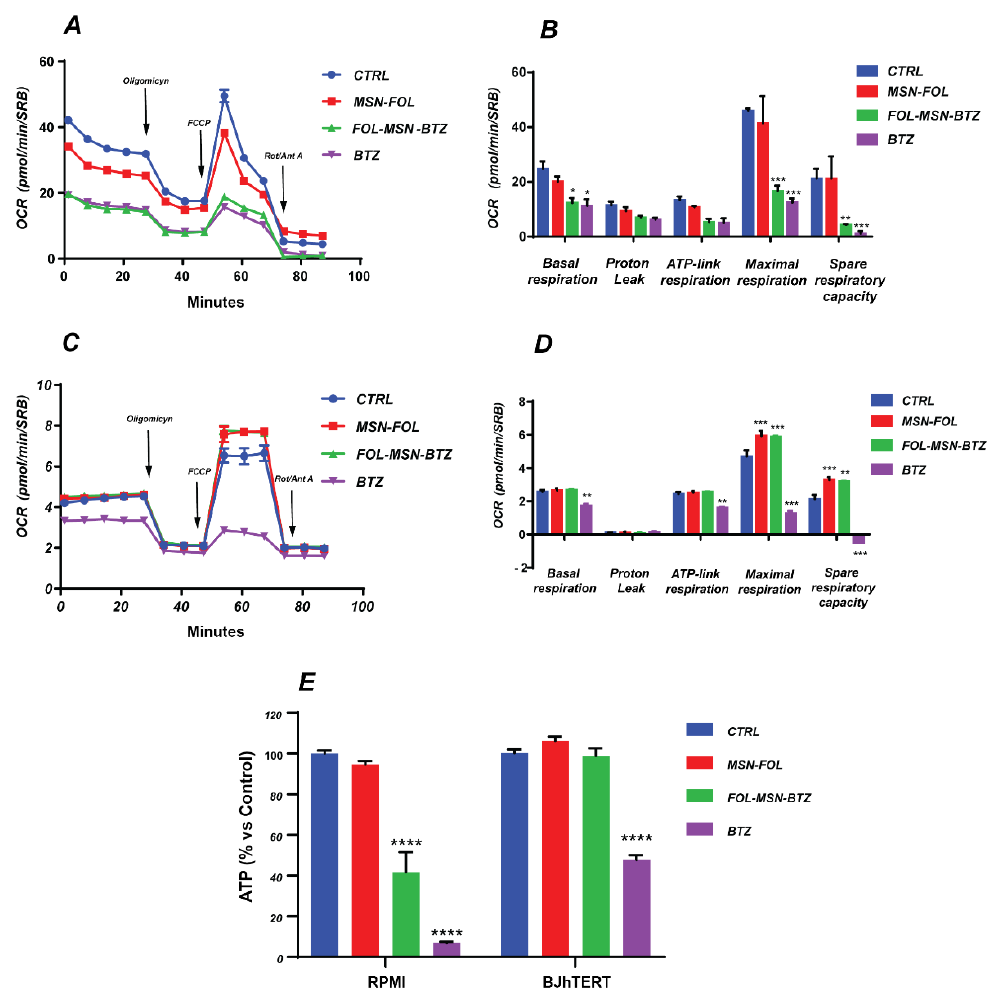
Figure 4. Mitochondrial signature induced by BTZ-loaded MSNs in RPMI-8226 and BJhTERT cell lines compared to the free BTZ. The mitochondrial profile of untreated (Control) cancer and normal cells or treated for 1 h with FOL-MSN-BTZ, MSN-FOL and BTZ (as positive control) was assessed 18 h after MSNs exposure using the Seahorse XF-e96 analyzer. Specific perturbations were serially injected at 30 min (Oligomycin), 50 min (FCCP) and 70 min (mix of rotenone and Antimycin A). A schematic tracing of OCR flux in RPMI-8226 ( A ) and BJhTERT ( C ) and graphic representation of the basal respiration, proton-leak, ATP-link respiration, maximal respiration and spare respiratory capacity in RPMI-8226 ( B ) and BJhTERT ( D ) are reported. ( E ) ATP profiling production in cancer and normal cells treated as in (A–D). Data are the mean ± SEM of three independent experiments performed in sextuplicate and normalized by protein content (SRB). (*) p < 0.05; (**) p < 0.01; (***) p < 0.001; (****) p < 0.0001.